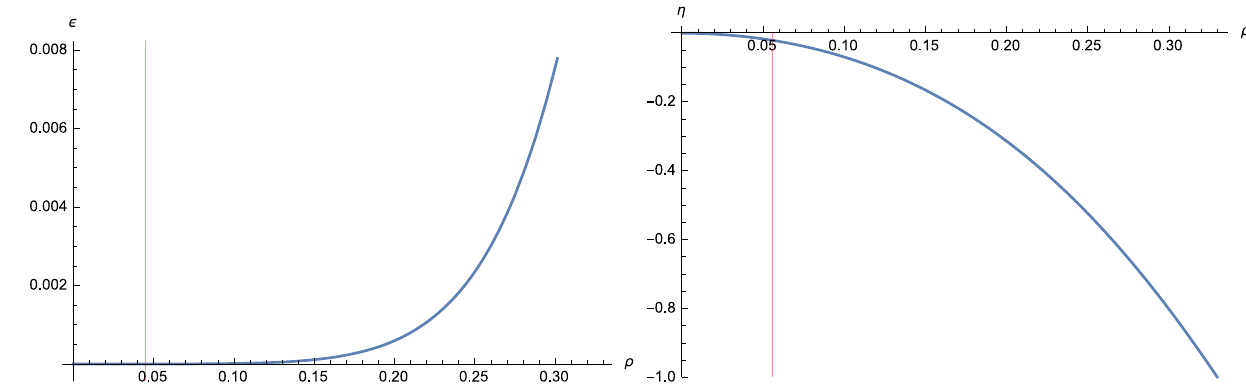
Fig. 4 A plot of (cid:14) and η versus ρ for the scalar potential given by Eq. (43) with the parameters in Eq. (48). The vertical (red) line indicates ρ ∗